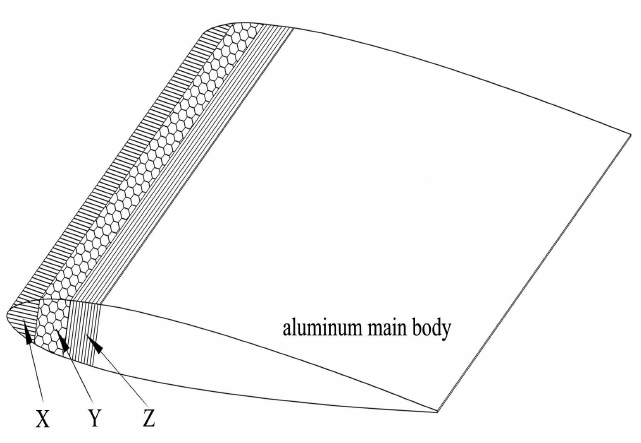
Figure 2. Illustration of the tested model (not to